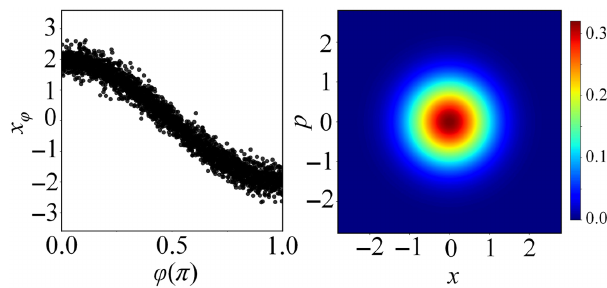
FIG. 15. Quantum tomography of an optical coherent state | α (cid:2) . In the left panel we show the calculated homodyne detection signal x φ , while the corresponding Wigner function centered at | α | = 2 is shown in the right panel. ((cid:13) x ) 2 = 1 / 2] remains constant along the cycle. All ϕ